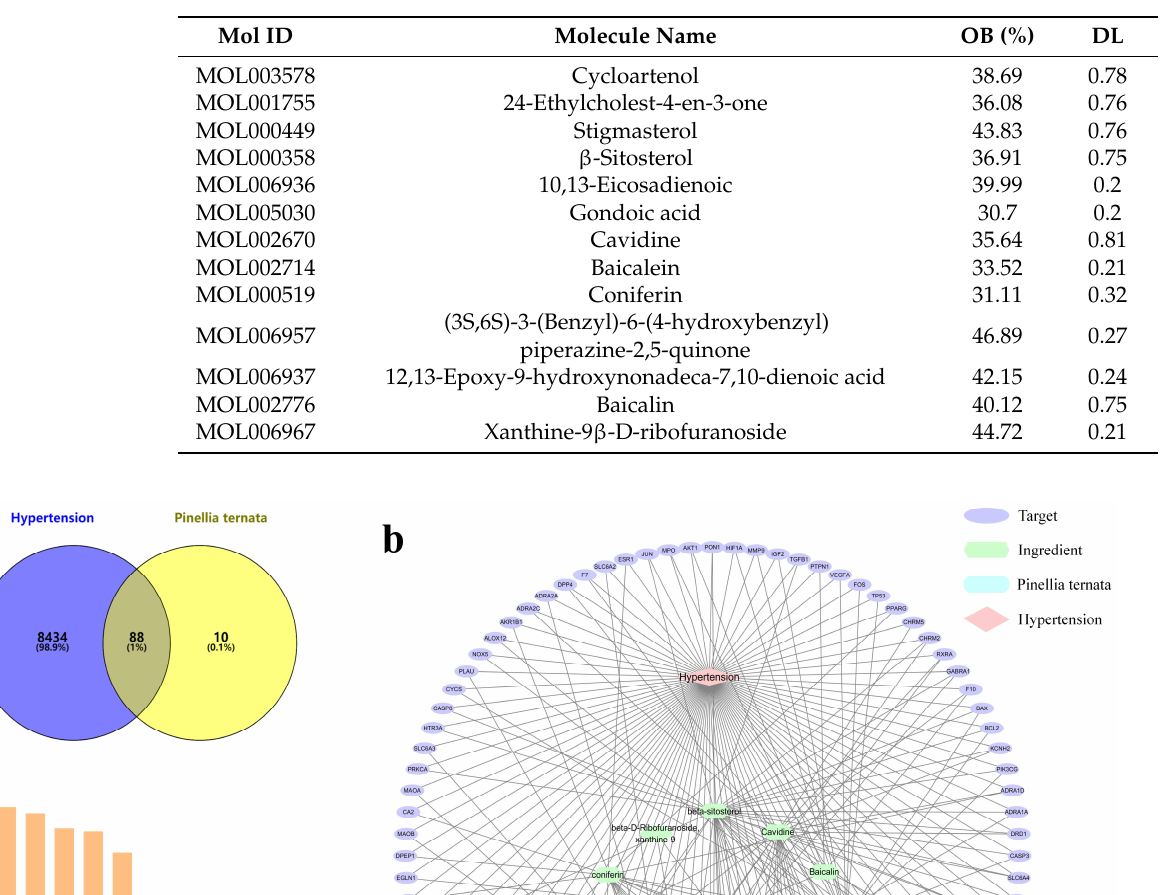
Table 1. Table of effective compounds of P. ternata.